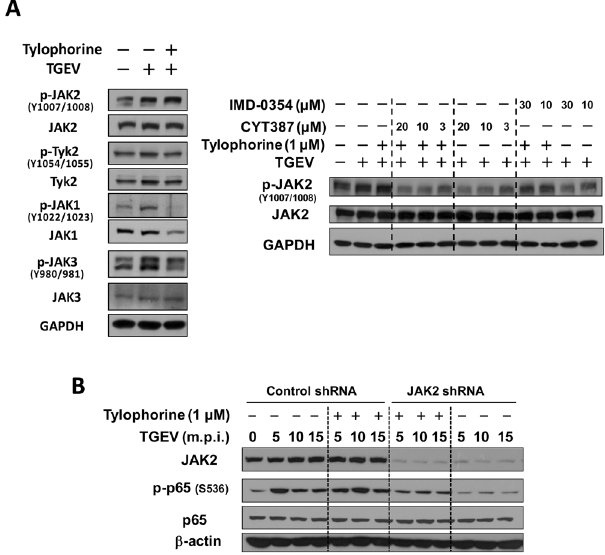
Figure 6. JAK2 mediated an alternative dominant p65 phosphorylation in TGEV infected ST cells. ( A ) CYT387 diminished JAK2 phosphorylation in the presence and absence of tylophorine in TGEV infected ST cells. Cells were treated with vehicle DMSO, tylophorine, IMD-0354, CYT387, or the combination of tylophorine and CYT387 for 1 h prior to TGEV infection and harvested at 15 m.p.i. for western analyses with the indicated antibodies for JAK1, p-JAK1, JAK2, p-JAK2, JAK3, p-JAK3, Tyk2, p-Tyk2, and GAPDH. The concentrations of IMD-0354 or CYT387 ( µ M) were used as indicated and 1 µ M of for tylophorine was used. ( B ) JAK2 knockdown diminished the phosphorylation of p65 in TGEV infected ST cells. Control shRNA or shJAK2 were transduced to ST cells to knockdown JAK2 expression. The resultant JAK2-knockdown ST cells or ST cells harbored control shRNA were infected by TGEV respectively at an MOI of 7 in presence or absence of 1 µ M tylophorine. Cells were harvested at 5, 10 and 15 m.p.i. of TGEV and the resultant cell lysates were subjected to western analysis with the indicated antibodies for JAK2, p65, p-p65 (S536) and β -actin. Uncropped images for Fig. 6 are presented in Supplementary Figure